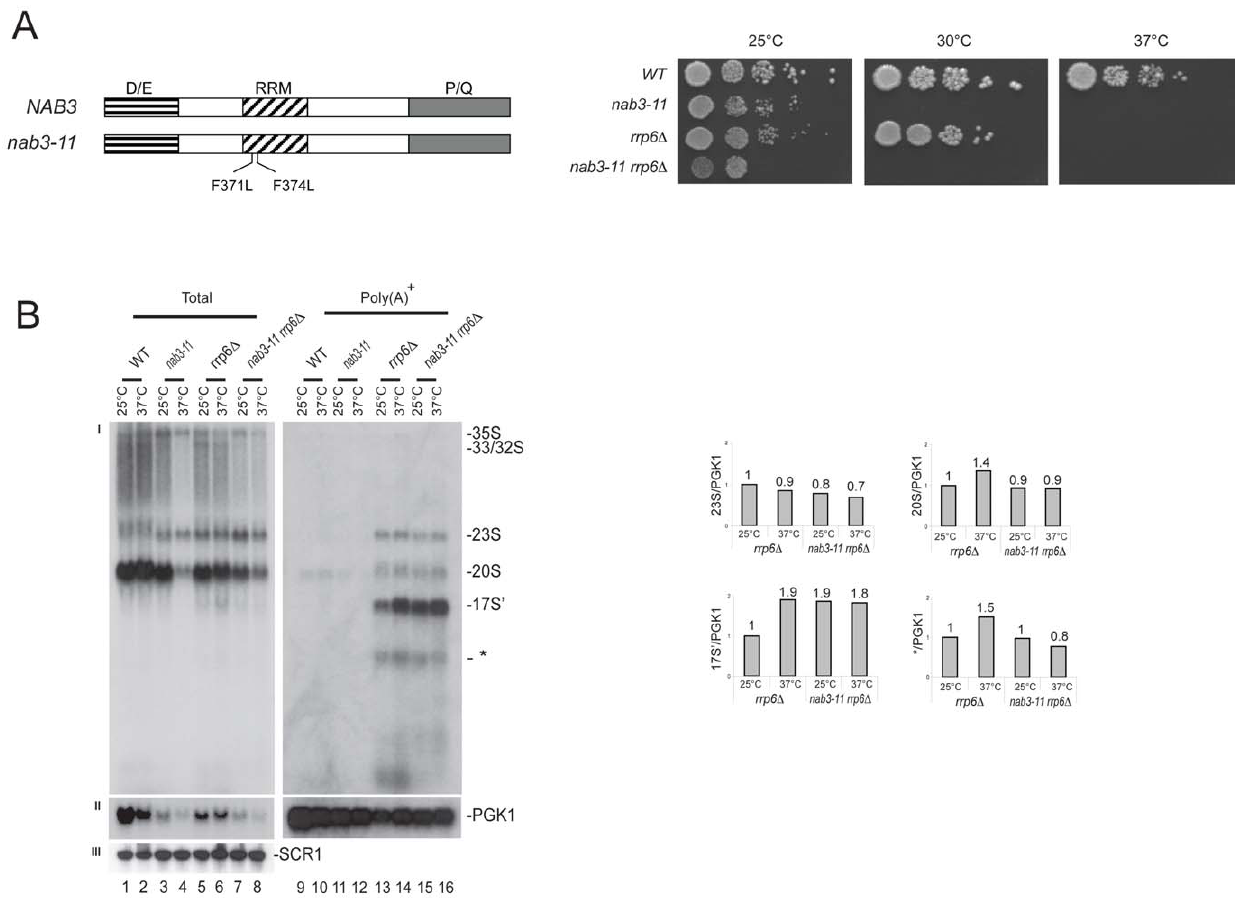
Figure 2. Involvement of the RRM domain of Nab3 in nucleolar surveillance. A, (left) Domain mapping of Nab3. Nab3 consists of an amino terminal D/E-rich, a central RRM and a carboxyl terminal P/Q-rich domain. The two amino acid substitutions in the RRM domain responsible for the thermosensitive phenotypes in the nab3-11 are indicated (provided by Prof. Jeff Corden, Johns Hopkins University School of Medicine). (right) Ten- fold serial dilutions of yeast cultures. Cells were grown on solid rich medium at the indicated temperatures for 2 d (30 u C and 37 u C) or 3 d (25 u C). B, Analysis of the Nab3 RRM mutation. (left) Northern-blot analysis of total and purified poly(A) + RNAs in different mutant background at the indicated temperatures (see legend to Fig 1). (right) Phosphor Imager quantitation. Histograms represent the relative distribution of specific RNA normalized to the PGK1 mRNA in different mutant background at different temperatures.